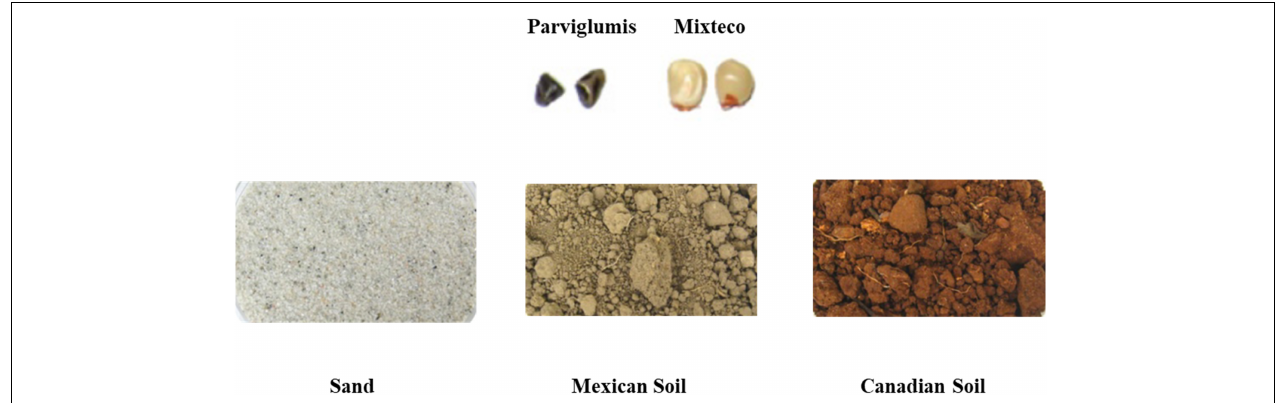
FIGURE 1 | Sources of root and shoot endophytes tested in this study. Endophytes were isolated from surface sterilized roots and shoots of Parviglumis and Mixteco grown in three different soils (including sterile sand) as part of a past study (Johnston-Monje et al., 2014).